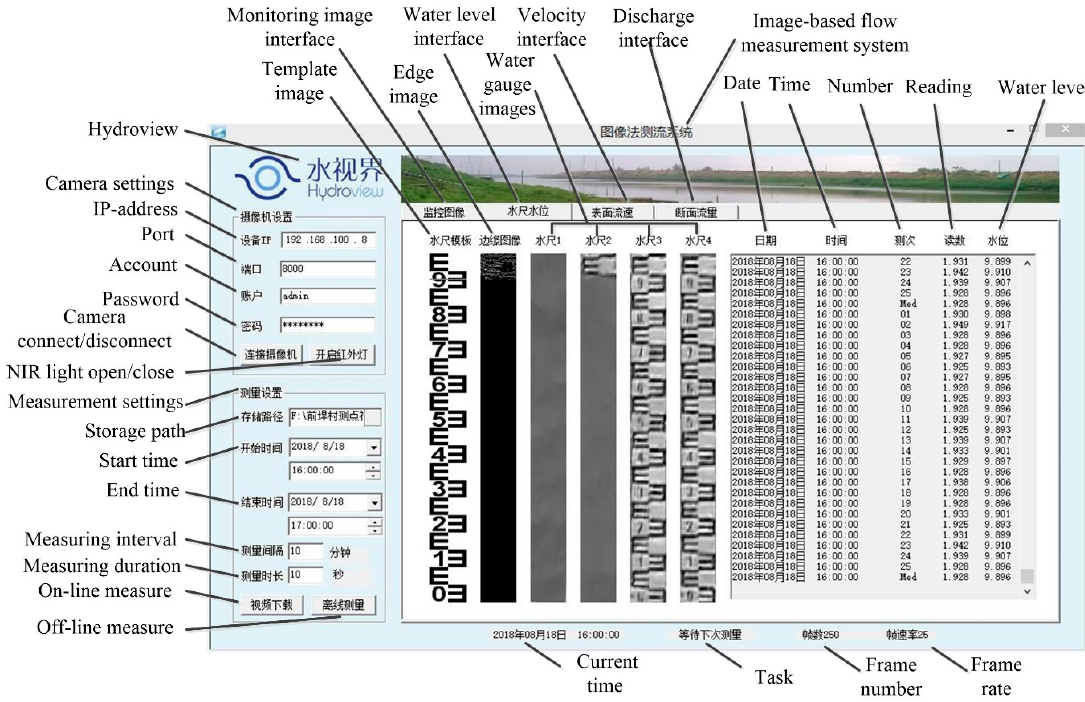
Figure 2. Graphical user interface (GUI) of image-based flow-level measurement software.